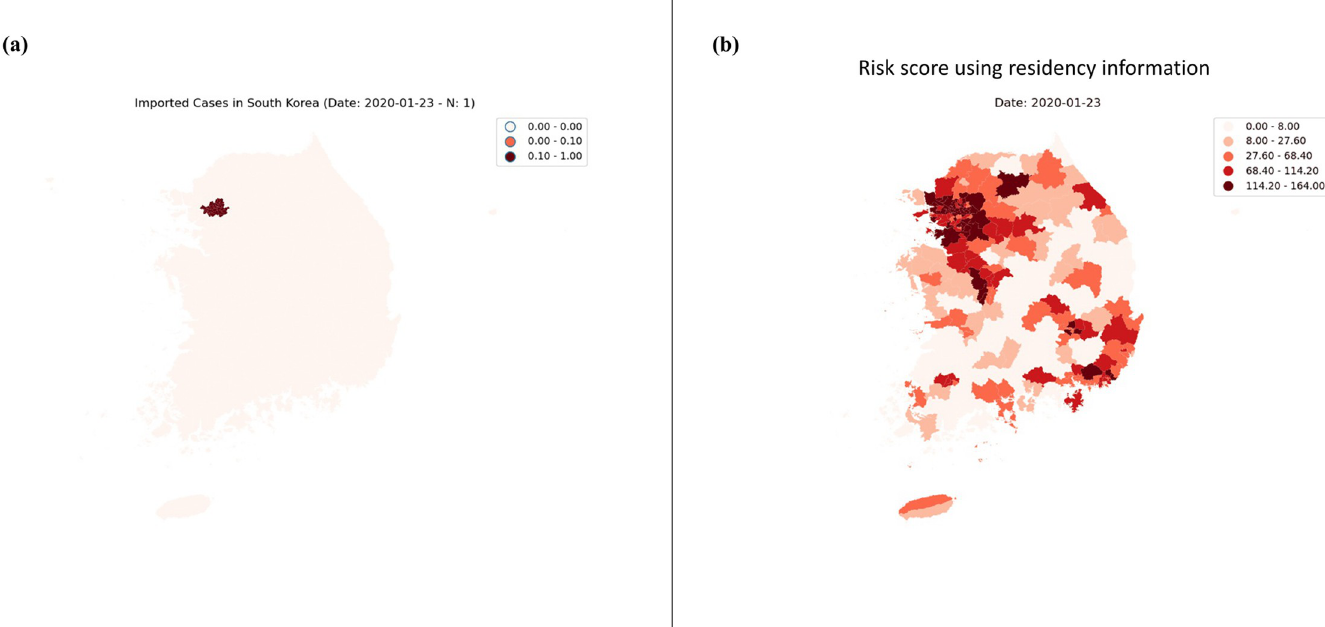
Fig 3. Heat maps of imported COVID-19 cases in South Korea. (A) Heat maps for the imported COVID-19 cases. (B) The risk score calculated using the roaming data. Darker shades of red indicate that more imported COVID-19 cases have been confirmed (A) and present a higher risk (B).